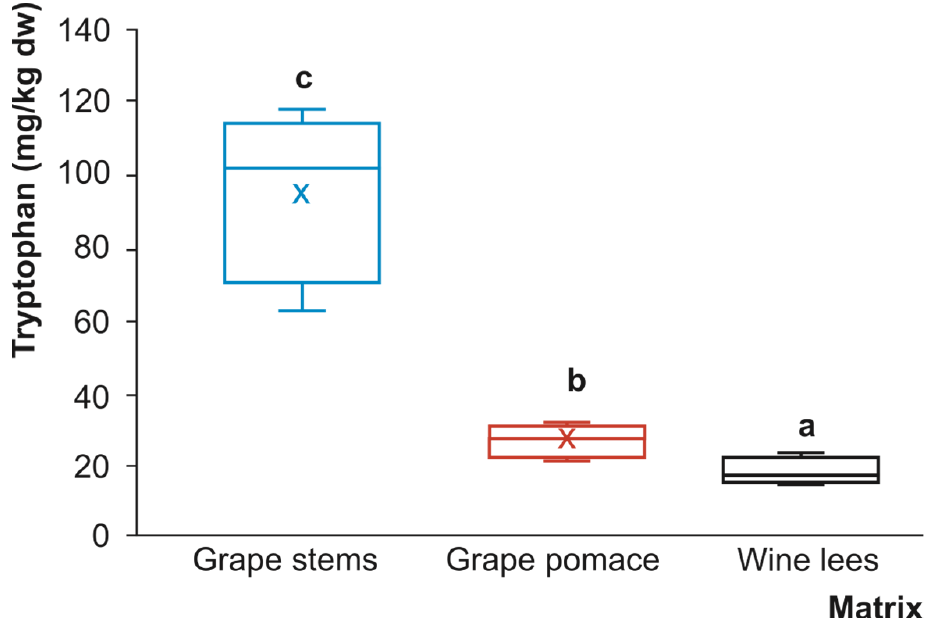
Figure 2. Box plots with quartiles (upper values of 75%, median values of 50%, and lower values of 25%) of tryptophan present in grape stems (blue box), grape pomace (red box), and wine lees (black box) (mg/kg dry weight (dw)) ( n = 4 for each by-product). Boxes with a different letter within each plot were statistically different at the significant level of p < 0.05 according to the analysis of variance (ANOVA) and Tukey’s multiple range test.